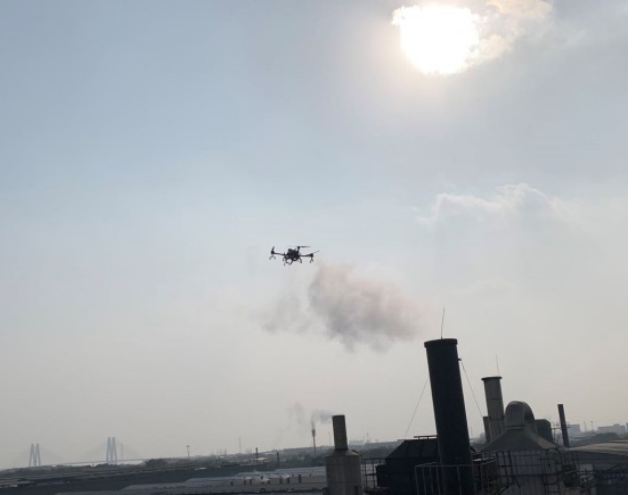
Figure 3. On-situ photograph of PM measurement from the chimney by a self-developed PM detector on an